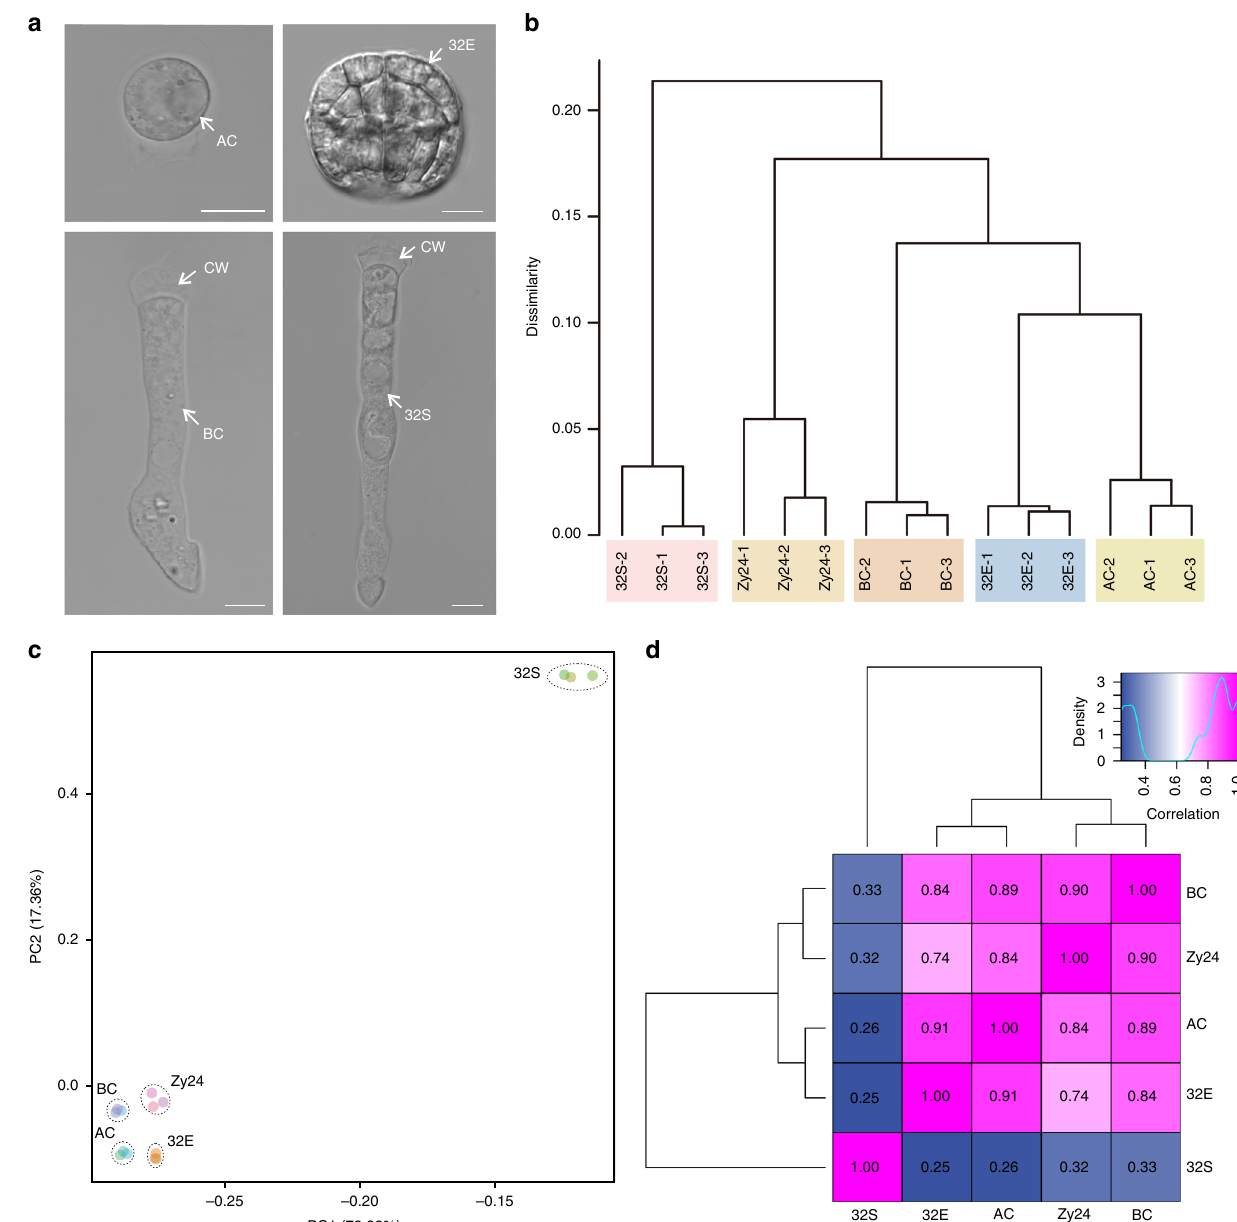
Fig. 1 Overall analyses of the transcriptomes of zygote, apical, and basal cell lineages of early proembryos. a Isolated living apical and basal cell lineages of early proembryos. Bar = 10 µ m. b , c Hierarchical clustering ( b ) and principal component analysis ( c ) of the transcriptomes of zygote, apical, and basal cell lineages of early proembryos. d Pearson ’ s correlation between the transcriptomes of zygote, apical, and basal cell lineages of early proembryos. CW cell wall, Zy24 zygote at 24 h after pollination, AC apical cell, BC basal cell, 32E embryo proper of 32-cell proembryo, 32S suspensor of 32-cell proembryo. Same abbreviations were also used in the following fi